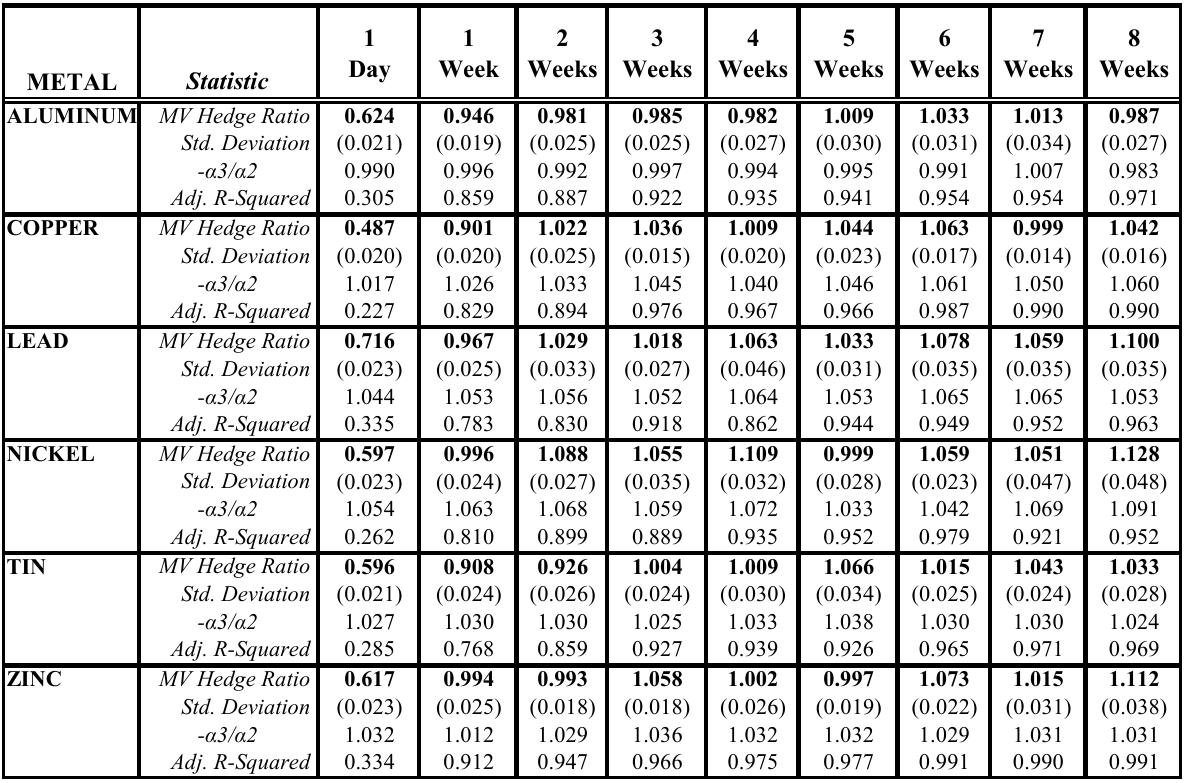
TABLE 6 – Joint Estimation of the Short-Run and Long-Run MV Hedge Ratios Table 6 reports the empirical results of estimating the optimal minimum variance hedge ratio for each of the six metal markets. The estimation in this table relies on Equation